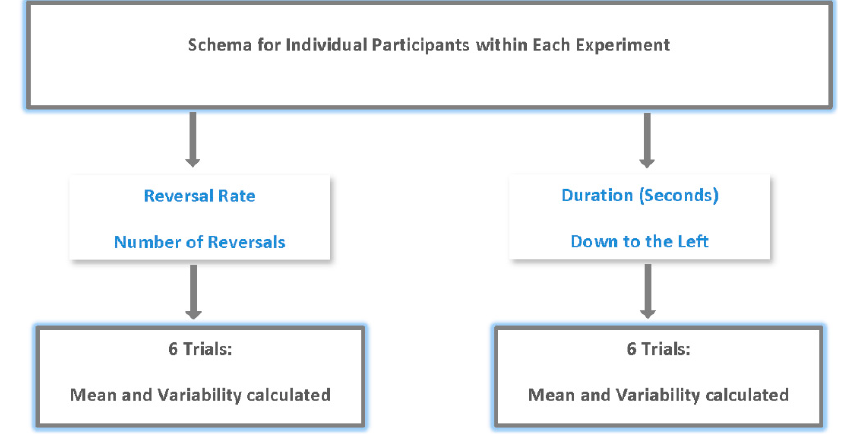
Figure 2. Schema of Individual participant trials